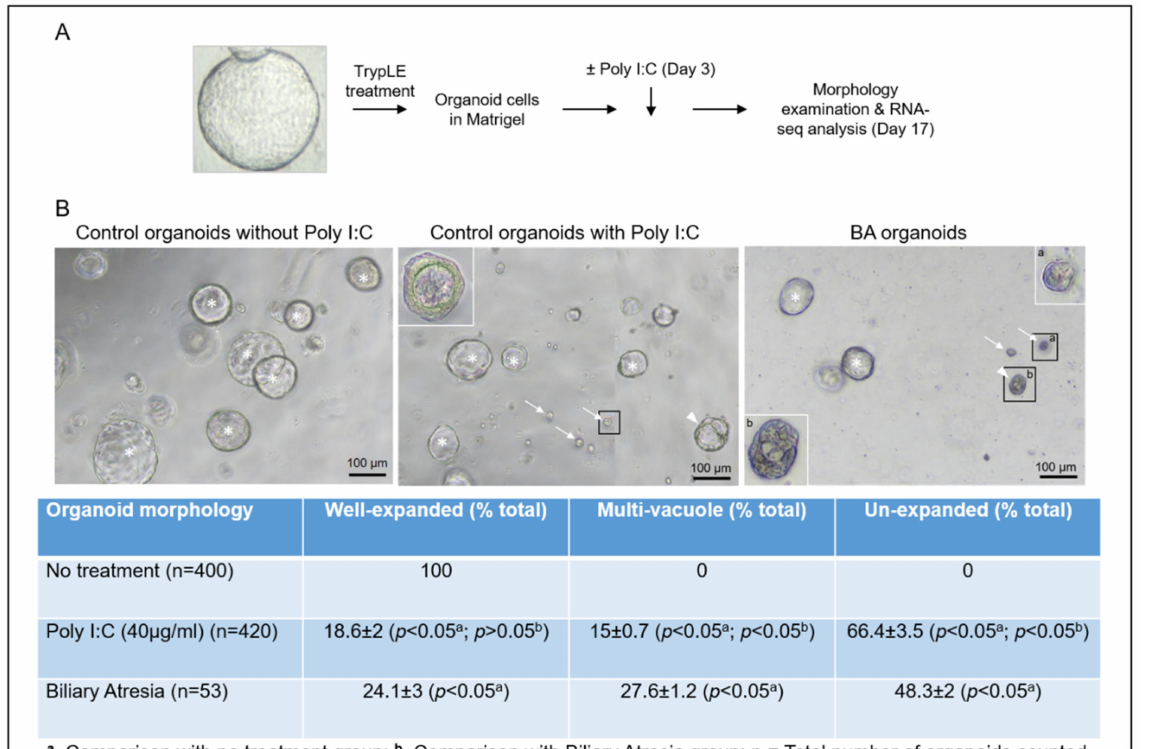
Figure 1. Poly I:C treated liver organoids were morphologically similar to BA liver organoids. ( A ) Schematic diagram of poly I:C treatment of normal liver tissue-derived organoids. ( B ) The morphology of liver organoids on day 17 from control samples without and with poly I:C treatment, and BA liver tissue-derived organoids (*, well-expanded mono-cystic spherical organoids with a single-cell layer of epithelial cells; arrowheads, poorly expanded structures with multiple vacuoles; arrow, tiny unexpanded cell clusters). The percentages (mean ± SD) of organoids of different morphologies in different groups were quantified and tabulated as